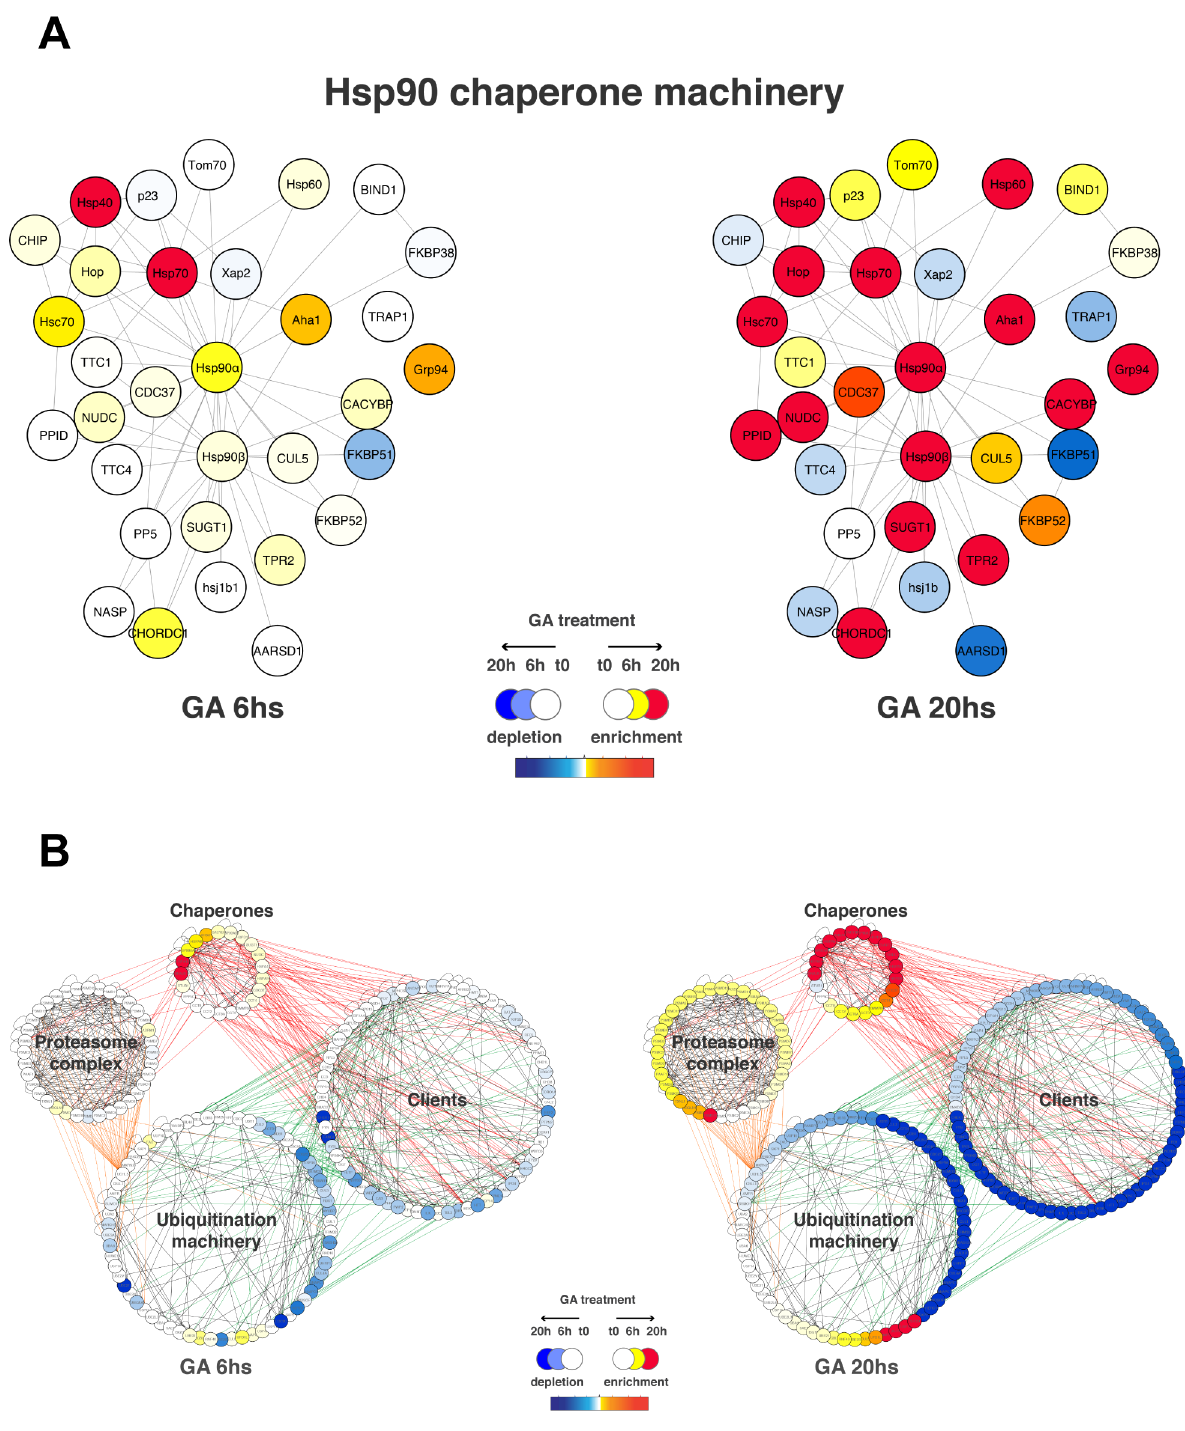
Figure 3. GA-induced remodeling of the Hsp90 chaperone and protein degradation machineries. A ) Components of the Hsp90 molecular chaperone machine (Hsp90Int, [21]) showing significant changes in the stSILAC data are schematized in a graph. Edges (lines) represent protein-protein interactions amongst members of the machinery. stSILAC data is integrated in the graph and represented as a colour gradient (red corresponds to enrichment, white is no change and blue is depletion) (see legend). B ) GA-induced changes of the proteasomal/ubiquitination machinery with connected Hsp90 clients. Members of the proteasomal complexes, ubiquitination machinery, molecular chaperones and known or potential Hsp90 client proteins are interconnected by edges indicating protein-protein interactions. Relative levels of proteins at 6h and at 20h after GA treatment are integrated in the graph and represented as a colour gradient (red corresponds to enrichment, white is no change and blue is depletion) (see legend).